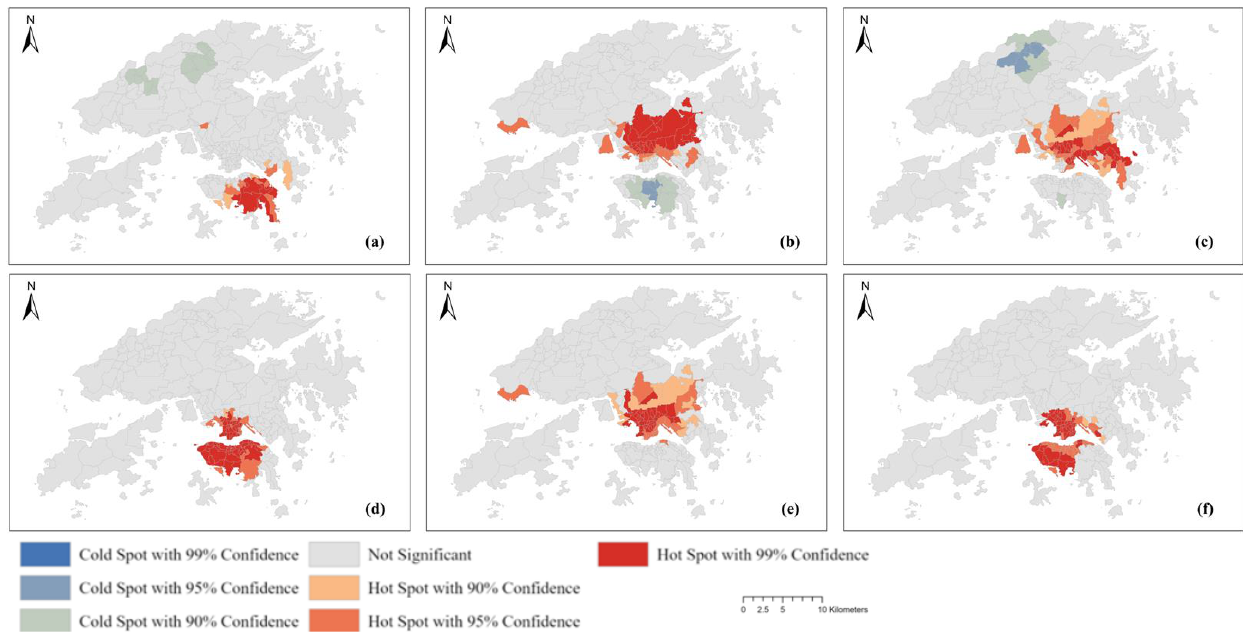
Figure 4. Spatial hotspot detection of COVID-19 incidence based on Getis-Ord Gi* statistics: ( a ) the hotspots in stage I of residential locations; ( b ) the hotspots in stage II of residential locations; ( c ) the hotspots in stage III of residential locations; ( d ) the hotspots in stage I of non-residential locations; ( e ) the hotspots in stage II of non-residential locations; ( f ) the hotspots in stage III of non-residential